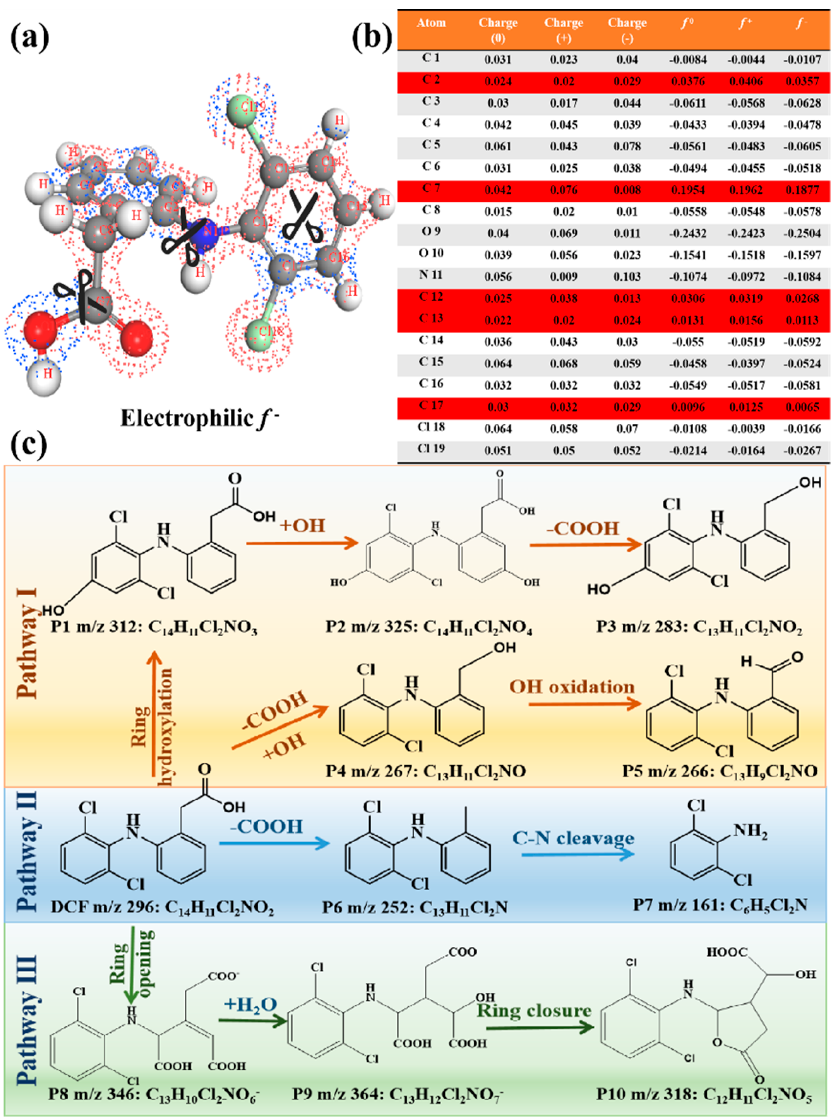
Figure 6. DCF electronic cloud density ( a ), NPA charge distribution and Fukui index of DCF ( b ), and degradation pathway of DCF ( c